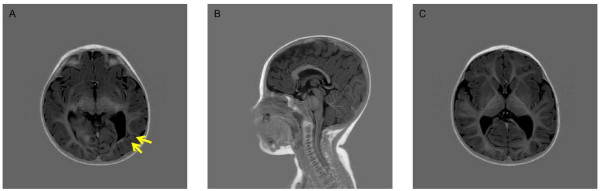
Brain MRI showing (A) possible brain atrophy and possible hemorrhage, (B) slight thinning of the corpus collosum posteriorly and (C) decrease in white matter volume seen posteriorly in the cerebral hemispheres bilaterally.